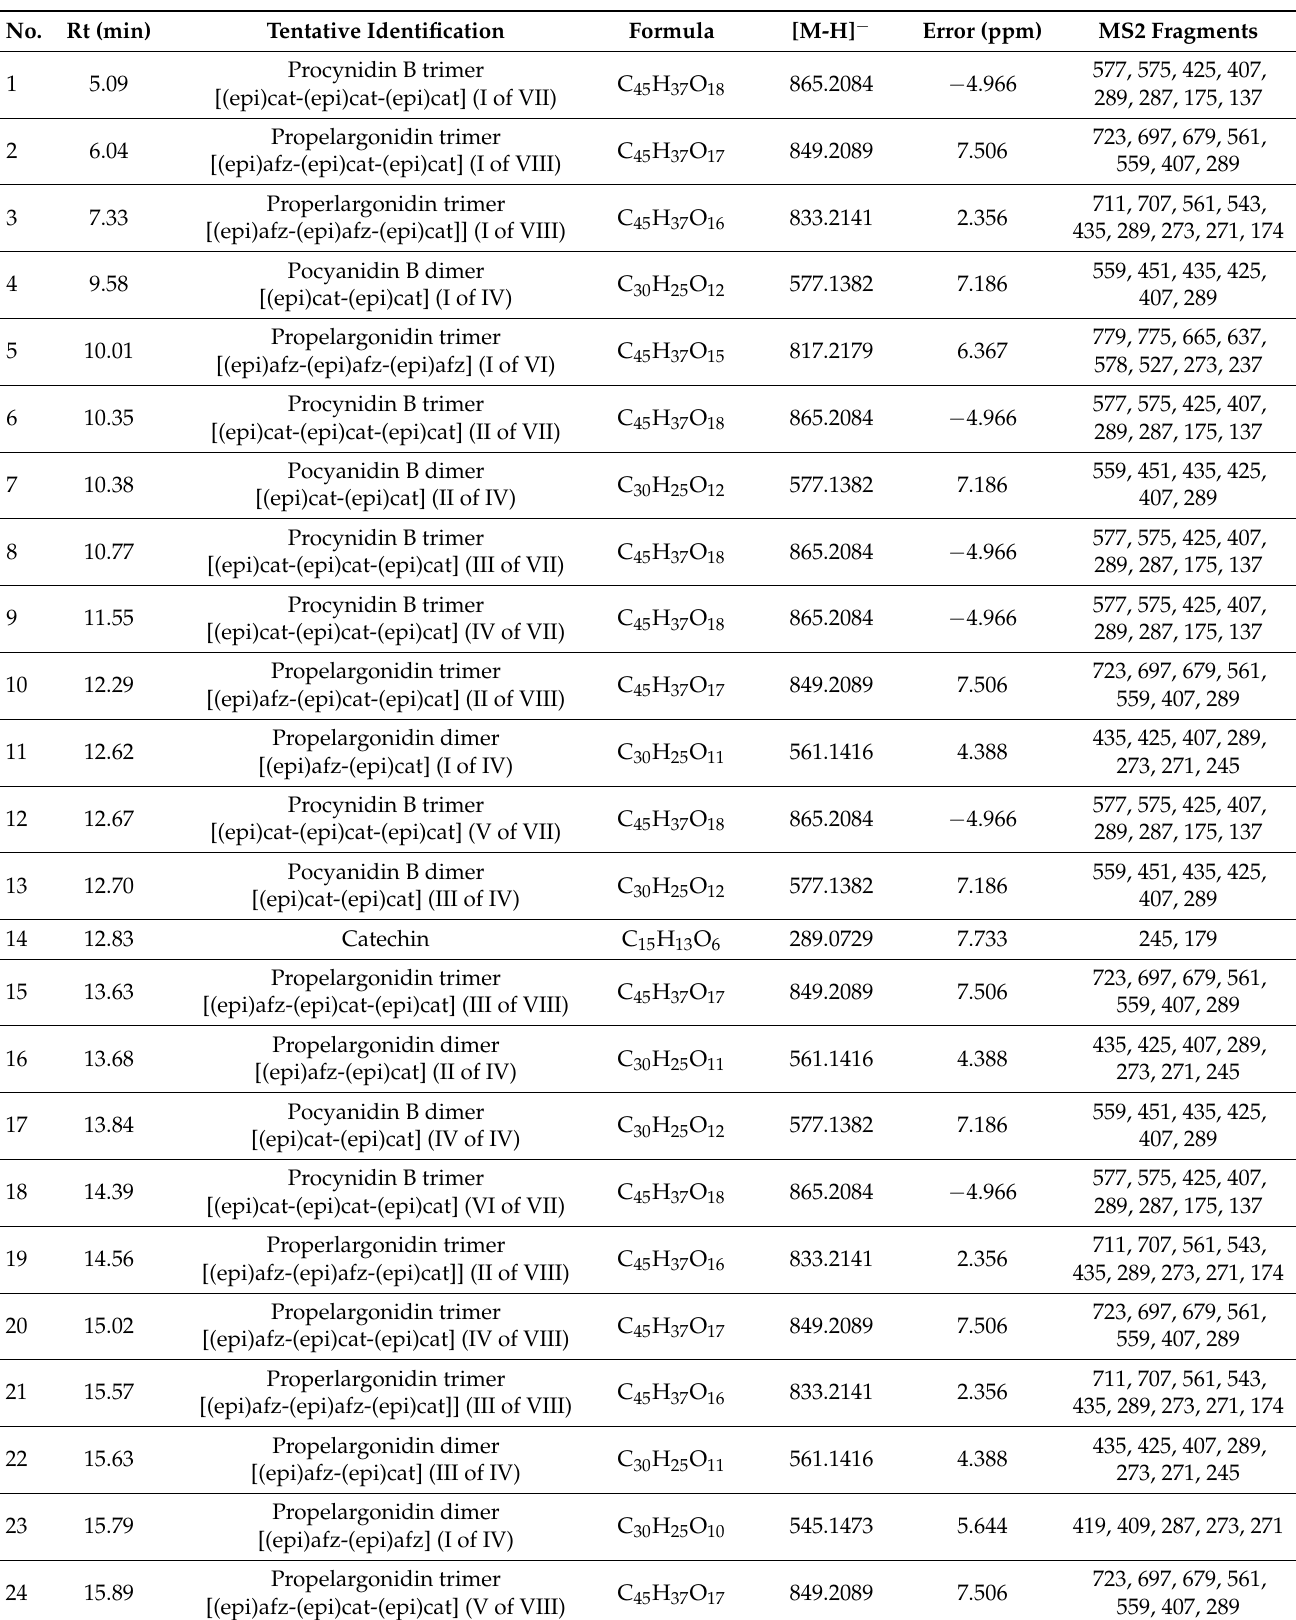
Table 1. Profile of proanthocyanidins and flavalignans identified by UPLC-QTOF-ESI MS analysis of U. tomentosa